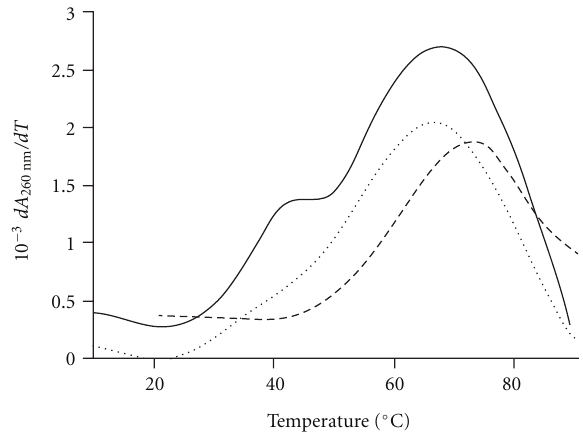
Figure 5: First derivative plot of melting curves followed by UV spectroscopy for hairpin PNA 4 alone (dashed line), TAR RNA alone (dotted line) and of hairpin PNA 4 /TAR complex (plain